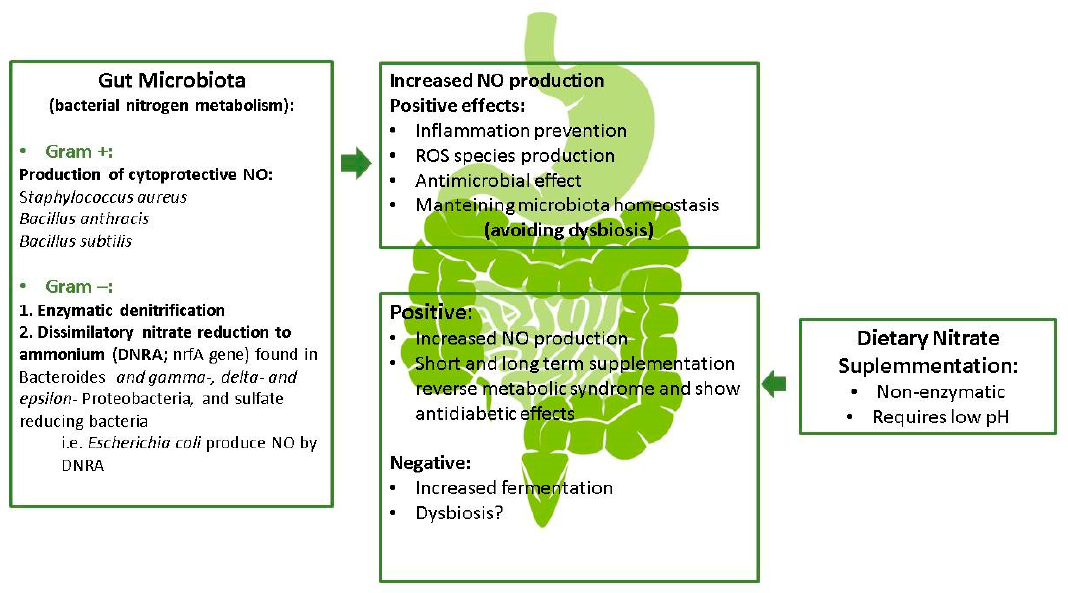
Figure 2. Potential role of nitrogen metabolism in gastrointestinal functions (modified).